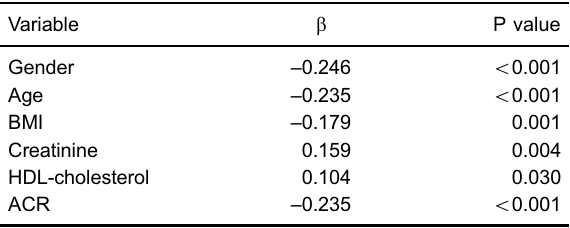
Table 3. Variables independently associated with serum 25(OH)D levels after multiple linear regression